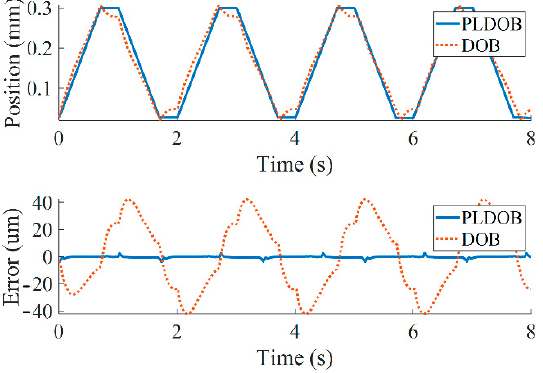
Figure 25. The experimental results of periodic adaptive disturbance observer (PADOB) on trapezoid trajectory tracking. Reprinted with permission from ref. [114]. Copyright 2018 CNKI.